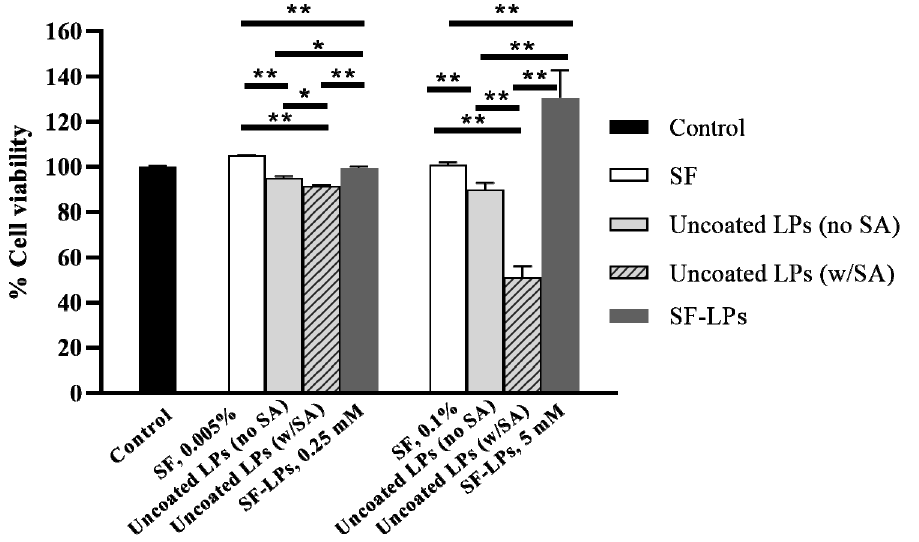
Figure 6. Cell viability of L929 fibroblasts when treated with components of uncoated liposomes (LPs) and SF-LPs. The uncoated liposomes containing SA showed a reduction in cell viability by 20%, whereas SF-LPs could enhance cell proliferation. The lipid compositions were soy PC, CH, and SA at 10:1:3 (molar ratio), with total phospholipid concentrations of 0.25 mM and 5 mM; SF 1% ( w/v ) was used for coating liposomes. ** p < 0.01; * p < 0.05